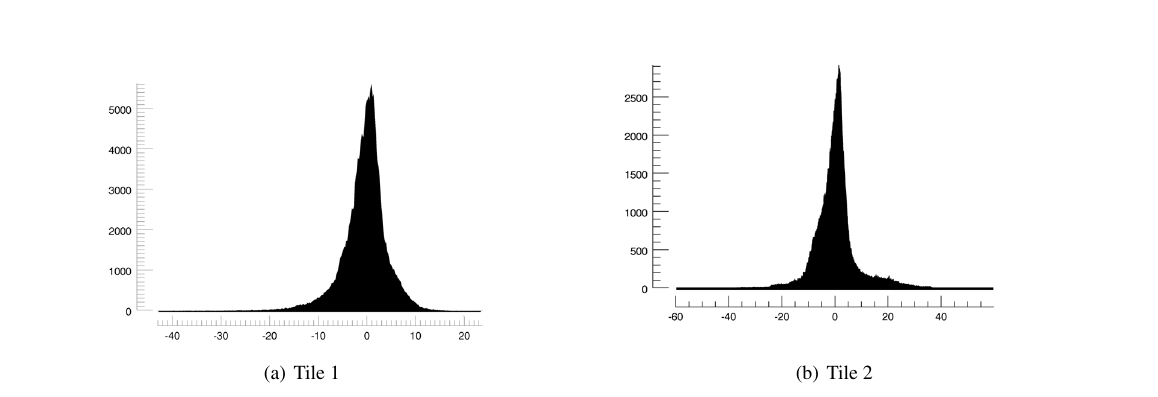
Figure 3: COSMO-SkyMed Tile 2 Analysis